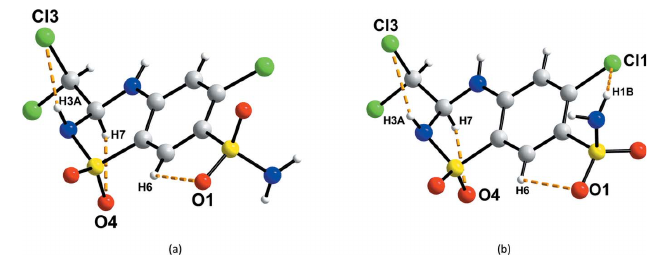
Figure 1 Molecular structure of RS -TCMZ with the atom- and ring-labelling